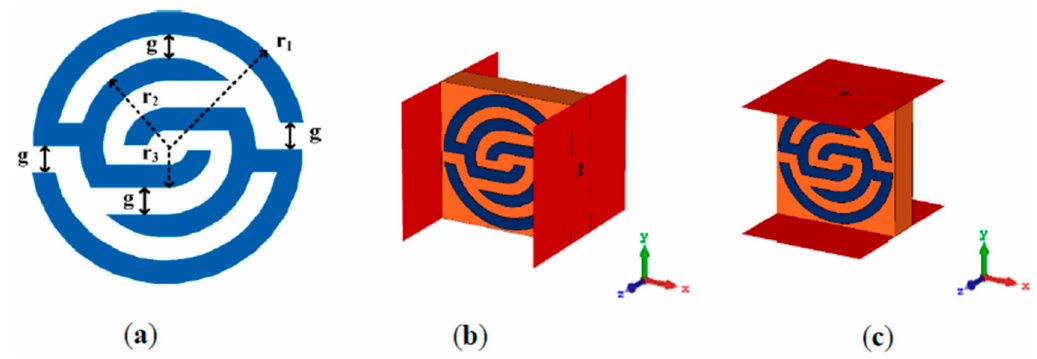
Figure 1. Metamaterial unit cell: ( a ) unit cell structure with g = 0.5 mm, r 1 = 2.9 mm, r 2 = 1.9 mm, r 3 = 0.9 mm; ( b ) simulation set-up in the x-axis; ( c ) simulation set-up in the